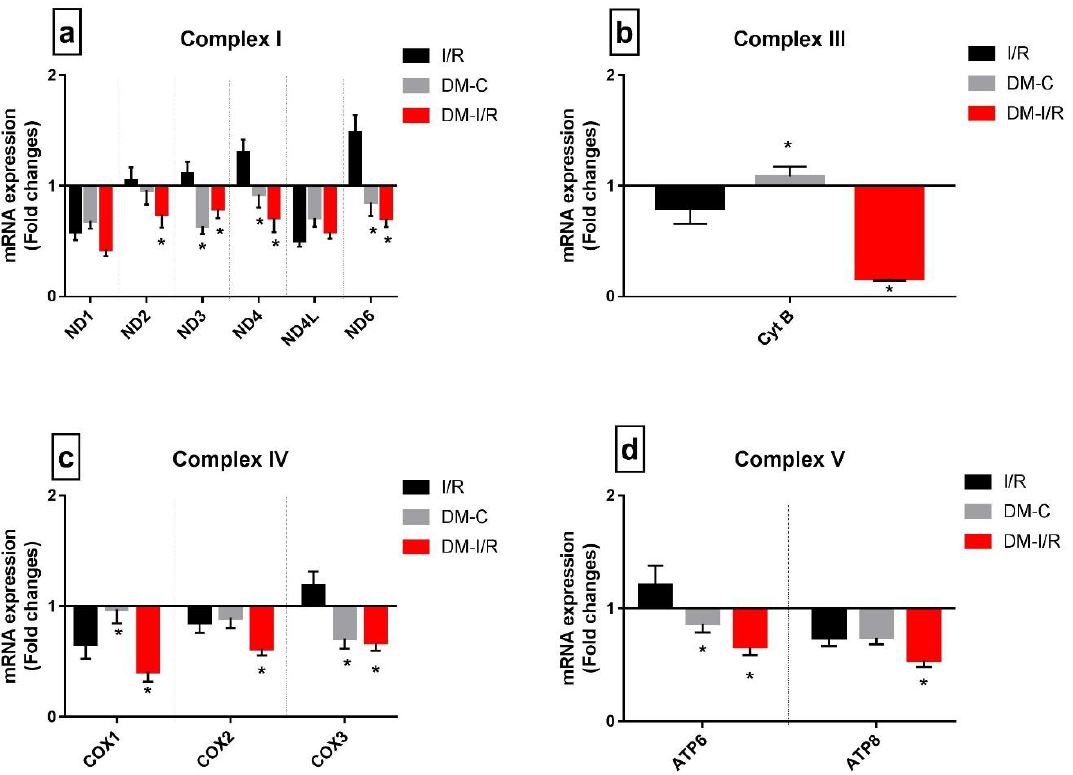
Figure 4. Impact of DM on the expression of mitochondrial-encoded ETC genes during I/R: The mRNA expression of mitochondrial-DNA-encoded genes are presented as fold changes from the normal group for ( a ) Complex I; ( b ) Complex III; ( c ) Complex IV; ( d ) Complex V. The graphs represent mean ± SD values. * p < 0.05 vs. I / R.